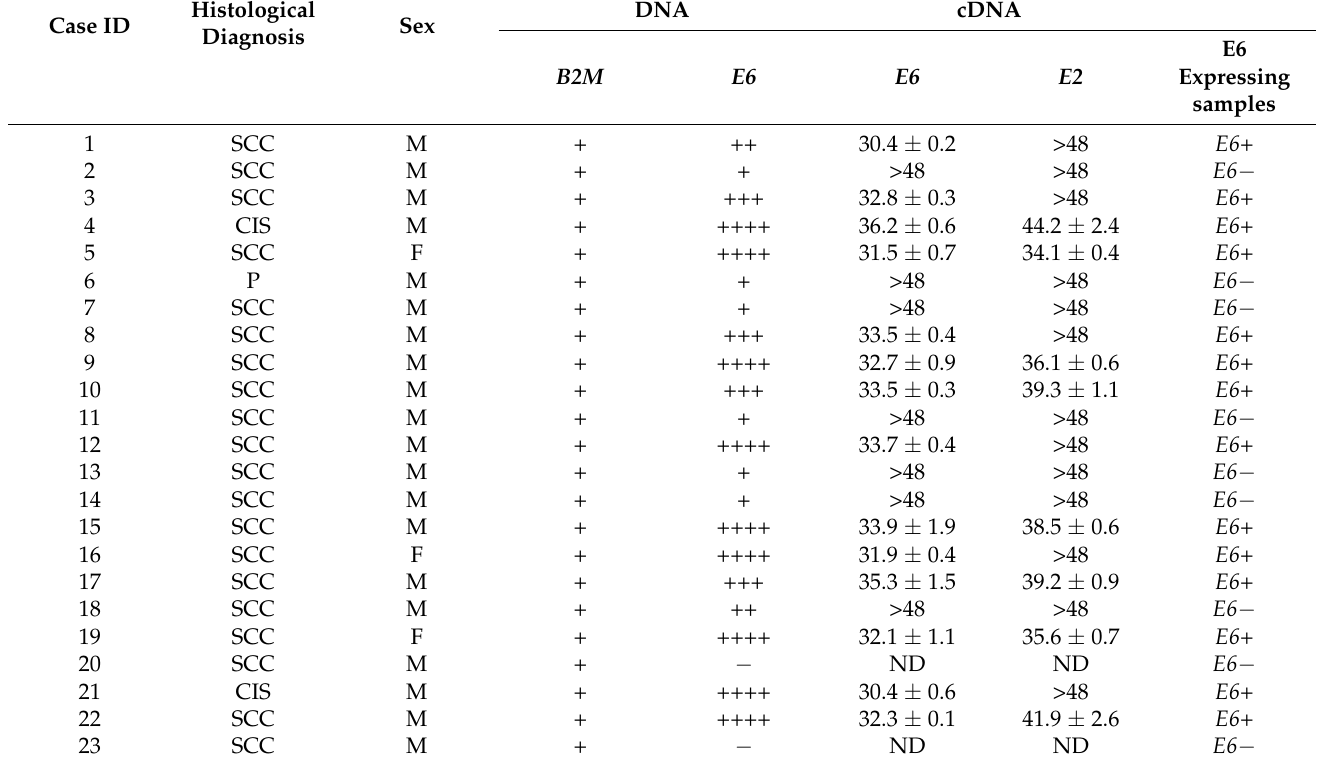
Table 4. Histological diagnosis: SCC: squamous cell carcinoma; CIS: carcinoma in situ; P: papilloma. RT-PCR data for beta-2-microglobulin (B2M) are expressed as + (amplified) or – (not amplified); indication of the viral amount was given through the Cq, at which point the positivity for E6 gene was detected: - (>38 Cq), + (34–38 Cq), ++ (29–33 Cq), +++ (23–28 Cq), and ++++ (18–22Cq). RT-qPCR data are expressed as mean Cq ± 1-standard deviation of three replicates. All samples were classified as E6+ when showing E6 expression (Cq < 48) and into E6 − when E6 gene was not expressed (Cq > 48). ND indicates no